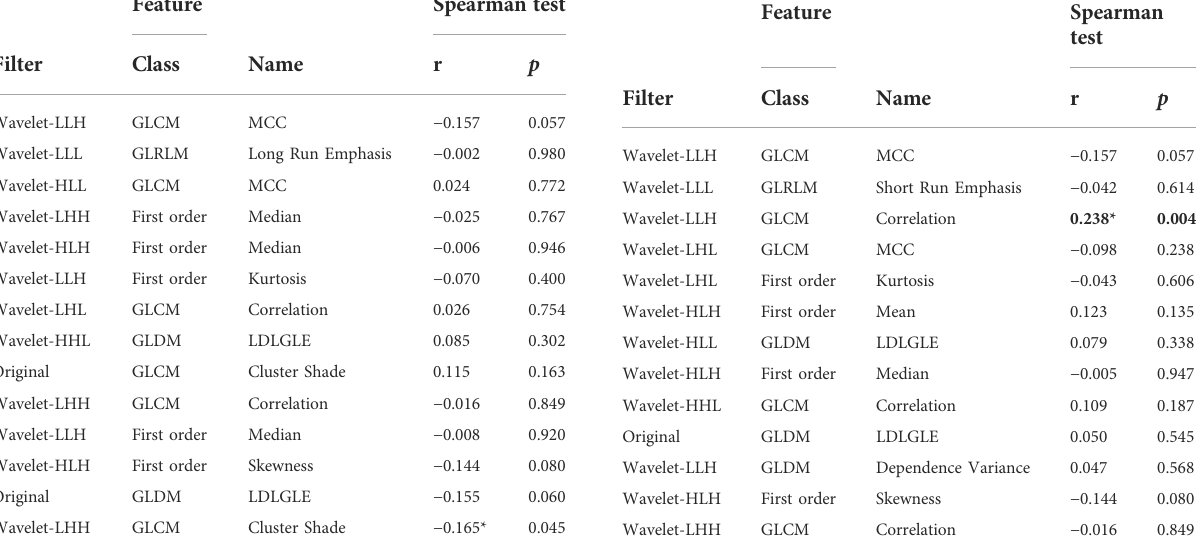
TABLE3CorrelationofPETtextureparametersselectedtopredictthe PLNM with same texture parameters of IHC image.